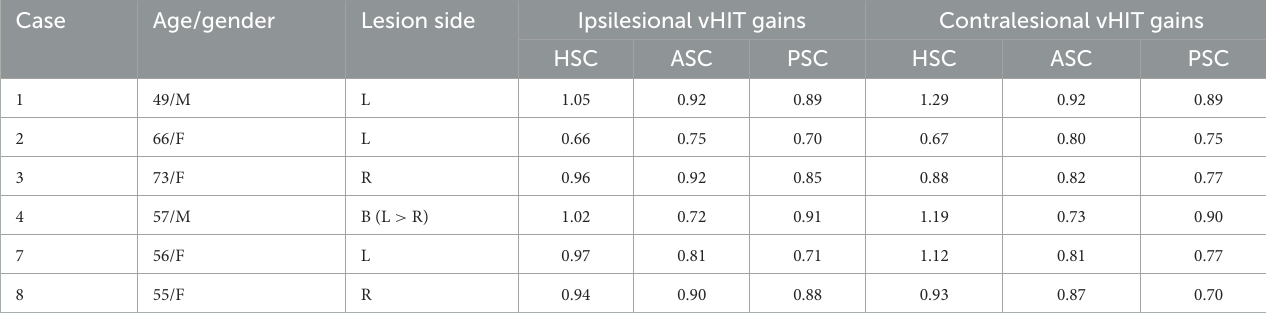
TABLE 2 vHIT gains in all six